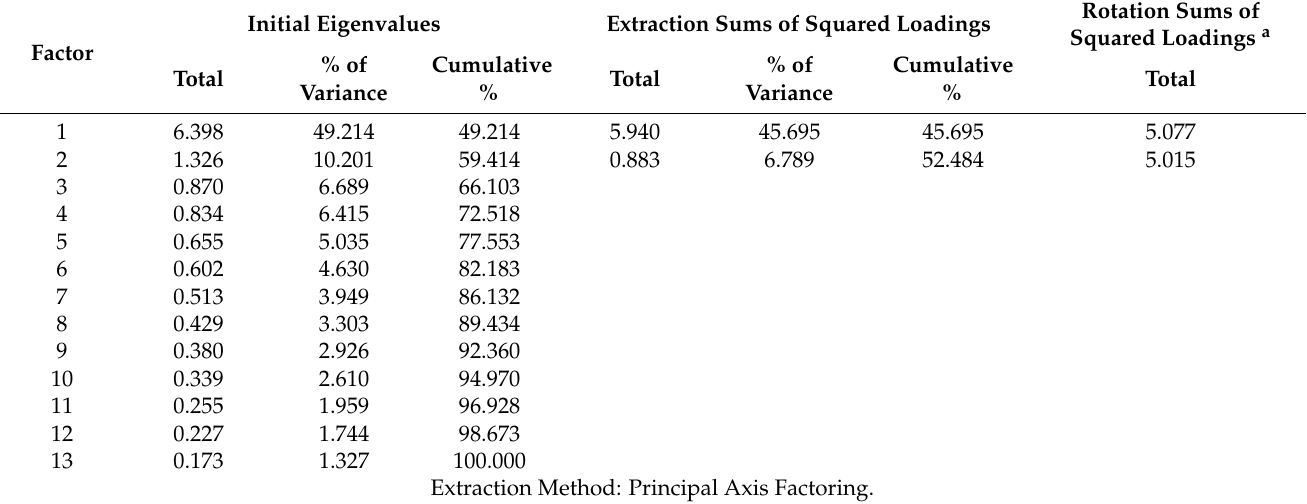
Table 4. Total variance explained.